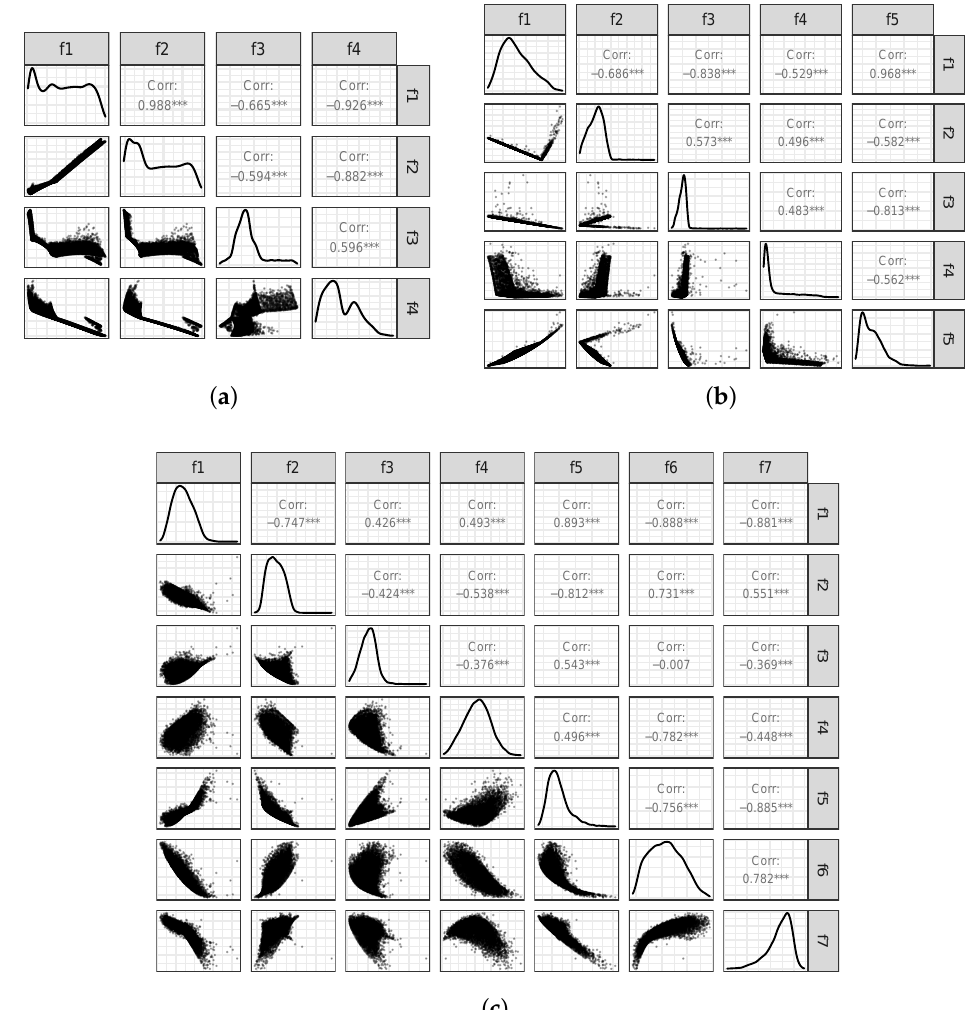
Figure 6. Pearson correlation coefficients between pairs of objectives for the three RWA problems. ( a ) RWA1; ( b ) RWA2; ( c )